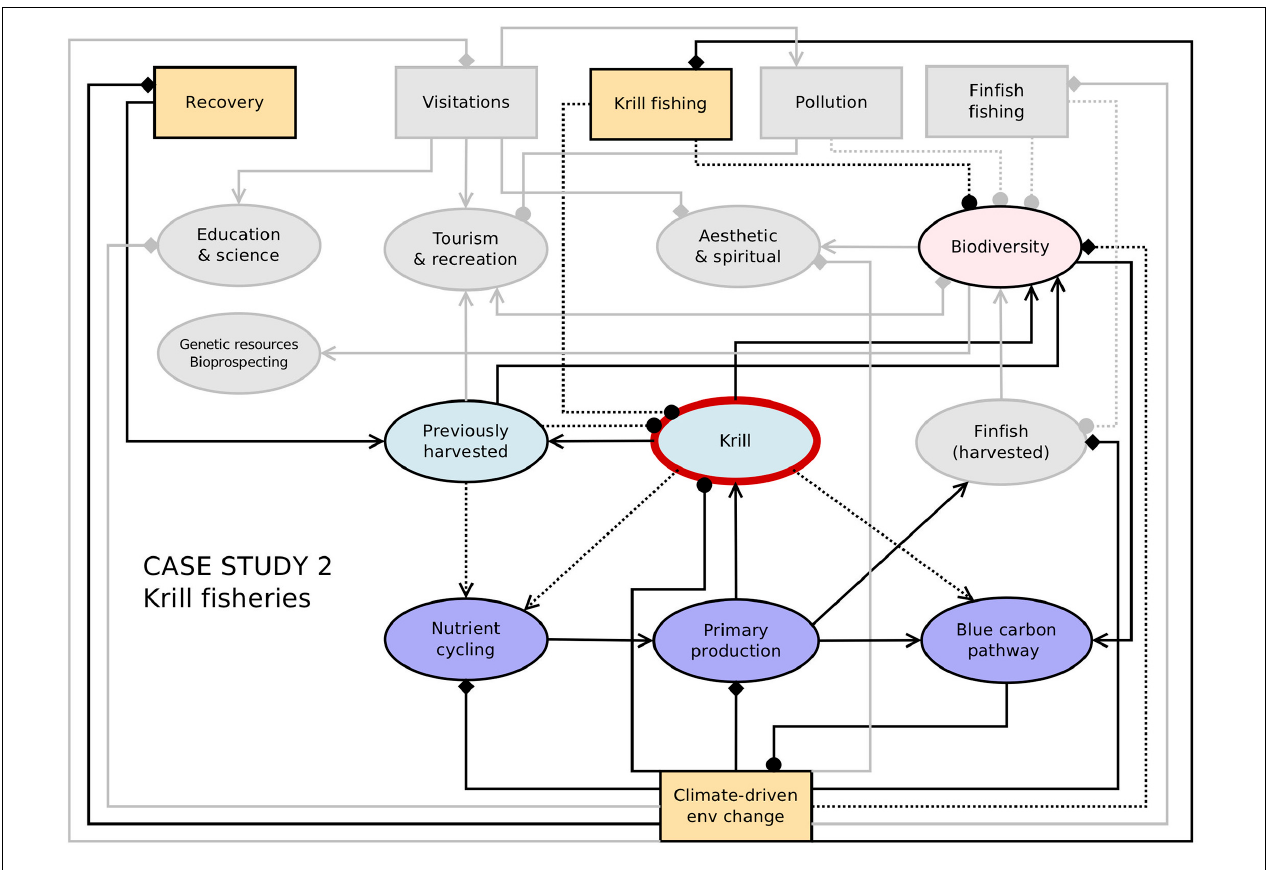
FIGURE 4 | Network representation of the links and feedbacks between ecosystem services and drivers (from Figure 2 ) with key elements for the Antarctic krill fishery highlighted. Connections between components indicate the direction of effects from one node to another, as indicated in the legend. Diamonds indicate cases where the direction of the effect is not known or unclear (i.e., it could be positive and/or negative), and dashed lines represent uncertain or weak